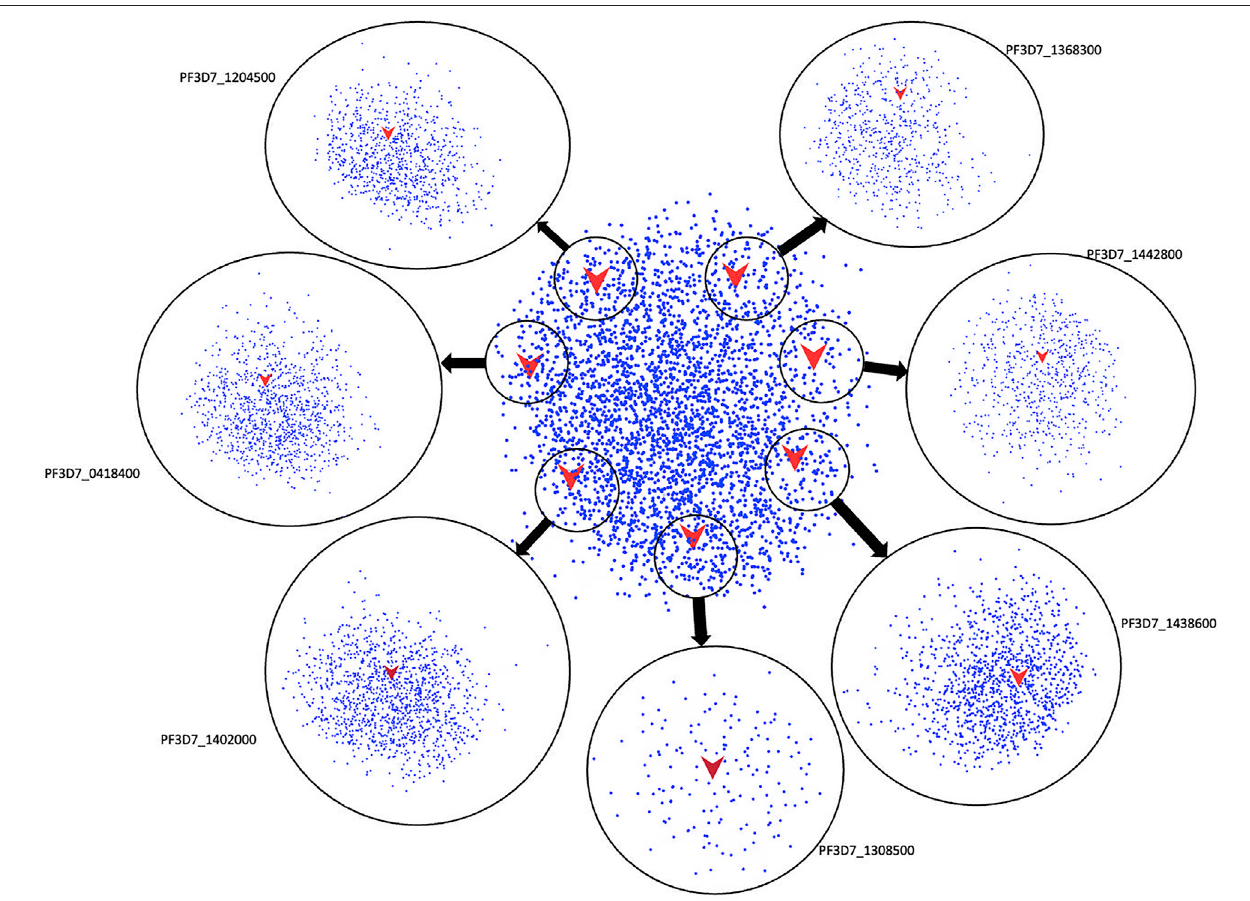
FIGURE5| Protein-Proteininteractionnetworks:TheoverallProtein-Proteininteractionnetworkoftheproteinsselectedasdrugtargetsinthecenterandindividual sub-networks of each protein with interacting nodes zoomed out as circles.